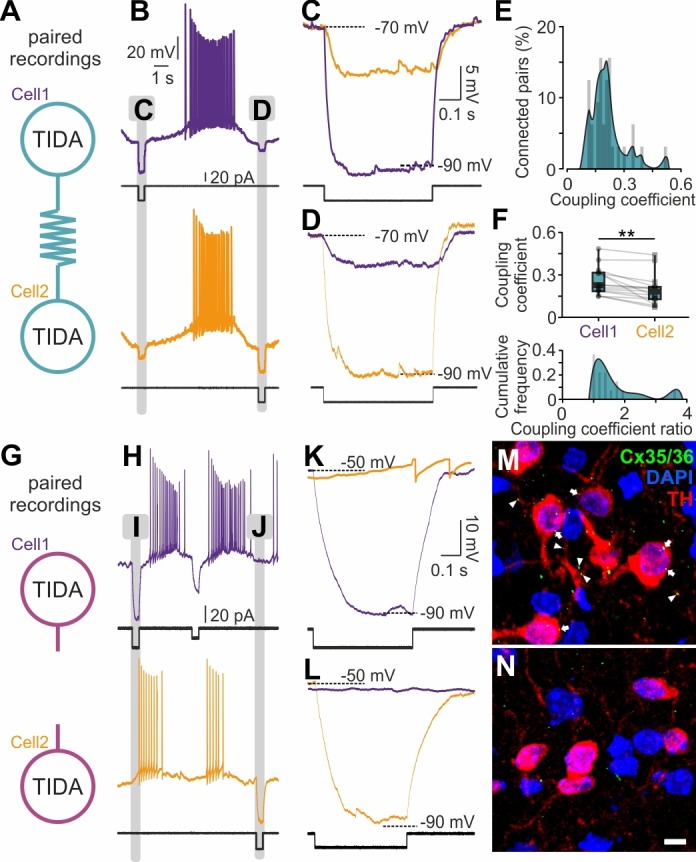
Electrical synapses in the rat but not in the mouse TIDA network.(A) Paired TIDA neuron recordings were performed to test for reciprocal electrical connectivity in rat slices. (B) Representative recording showing bidirectional electrical coupling in rat slices. Example trace illustrating the effect of negative current injection first into cell one and then into cell 2. (C,D,) High-resolution trace during negative current injection. Note the different response amplitude in cell1 vs cell2, suggestive of asymmetrical electrical synapses. (E) Frequency distribution of the coupling coefficient, average 0.18 ± 0.02, n = 32 pairs. (F) Top; Different coupling coefficient between cell 1 and cell 2, indicative of asymmetrical electrical synapses (n = 16, p<0.01, unpaired t-test). Bottom; Cumulative frequency of the coupling coefficient ratio, indicative of the high-degree of functional coupling asymmetry. (G) Similar to (A) paired recordings were performed in mouse TIDA neurons. (H) Representative recording showing the absence of electrical coupling in mouse slices. Example trace illustrating the effect of negative current injection first into cell 1 and then into cell 2. (I) and J) indicate portions of recordings illustrated at higher resolution in (K) and (L), respectively. (K, L,) High-resolution traces illustrating lack of electrical coupling between mouse TIDA neurons (n = 40 pairs). (M, N,) Cx35/36 immunostaining (green) of the dmArc shows punctate presumed gap junctions (arrows) on the soma and dendrites of rat (M), but not mouse (N), TIDA neurons. TH (red) used to identify TIDA neurons, DAPI (blue) shows cell nuclei. Scale bars for (M N) 10 µm.